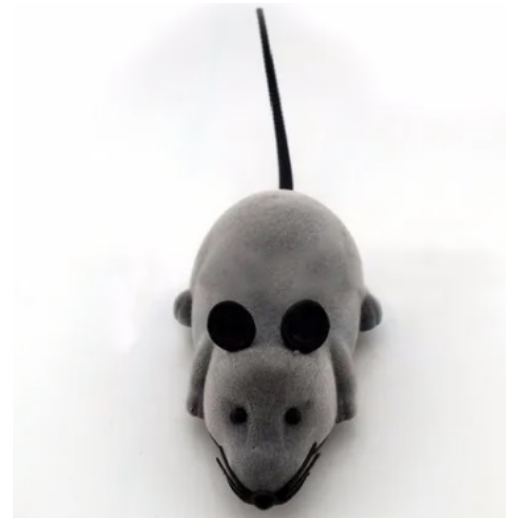
Figure 19. Remote control